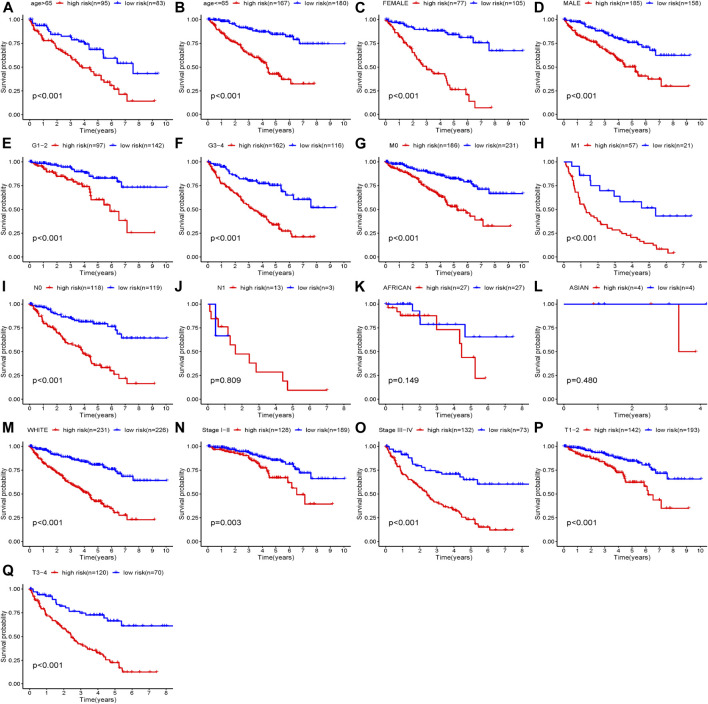
Clinical parameters stratified by our established riskScore for OS; (A) Age>65 stratified by riskScore for OS; (B) Age<=65 stratified by riskScore for OS; (C) Female stratified by riskScore for OS; (D) Male stratified by riskScore for OS; (E) Grade1-2 stratified by riskScore for OS; (F) Grade3-4 stratified by riskScore for OS; (G) M0 stratified by riskScore for OS; (H) M1 stratified by riskScore for OS; (I) N0 stratified by riskScore for OS; (J) N1 stratified by riskScore for OS; (K) African stratified by riskScore for OS; (L) Asian stratified by riskScore for OS; (M) White stratified by riskScore for OS; (N) Stage I-II stratified by riskScore for OS; (O) Stage III-IV stratified by riskScore for OS; (P) T1-2 stage stratified by riskScore for OS; (Q) T3-4 stage stratified by riskScore for OS.